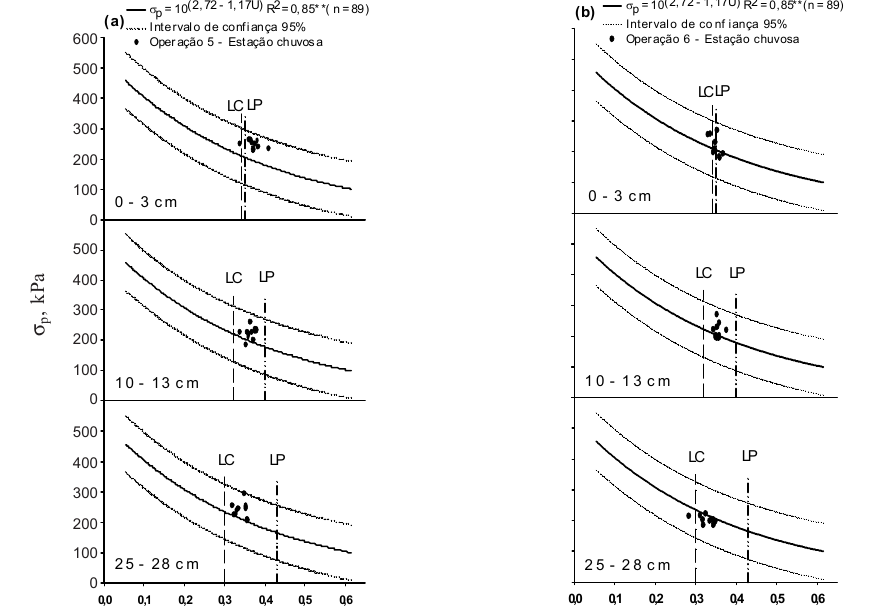
Figura 5. Modelo de capacidade de suporte de carga para o Latossolo Amarelo distrófico típico nas camadas de 0–3, 10–13 e 25–28 cm com seus respectivos limites de contração (LC) e de plasticidade (LP). Os pontos representam as pressões de preconsolidação determinadas após as operações da adubadora tracionada pelo trator Massey Ferguson 50X na estação chuvosa (Operação 5) (a), as pressões de preconsolidação determinadas após a operação do aplicador de herbicida tracionado pelo trator Massey Ferguson 265 na estação chuvosa (Operação 6) (b).